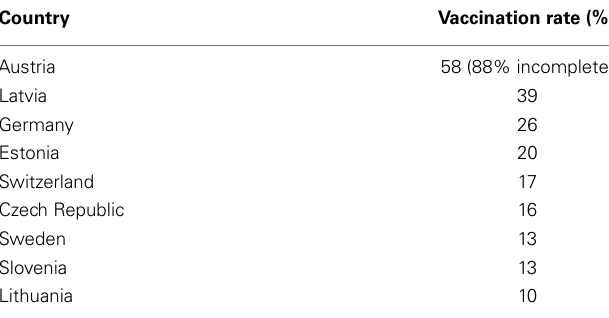
Table 1 |Vaccination rates of different European countries 2007–2009 .